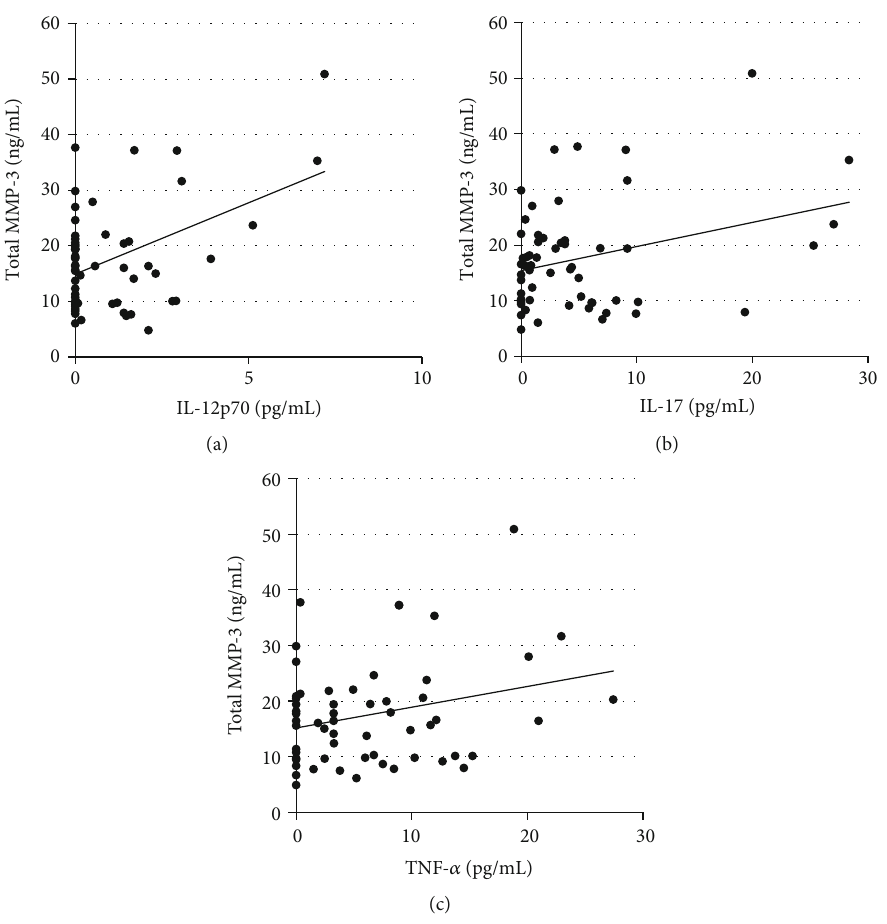
Figure 1: Correlations of total MMP-3 with (a) IL-12p70, (b) IL-17A, and (c) TNF- α